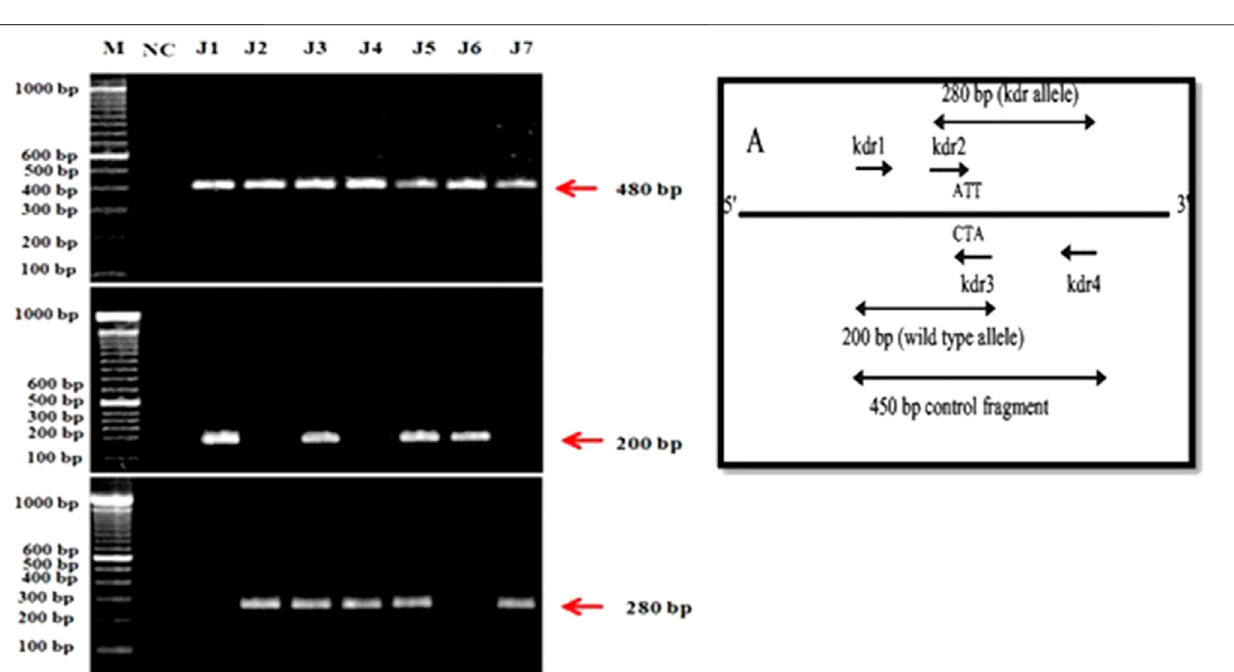
Frontiers in Environmental Science |